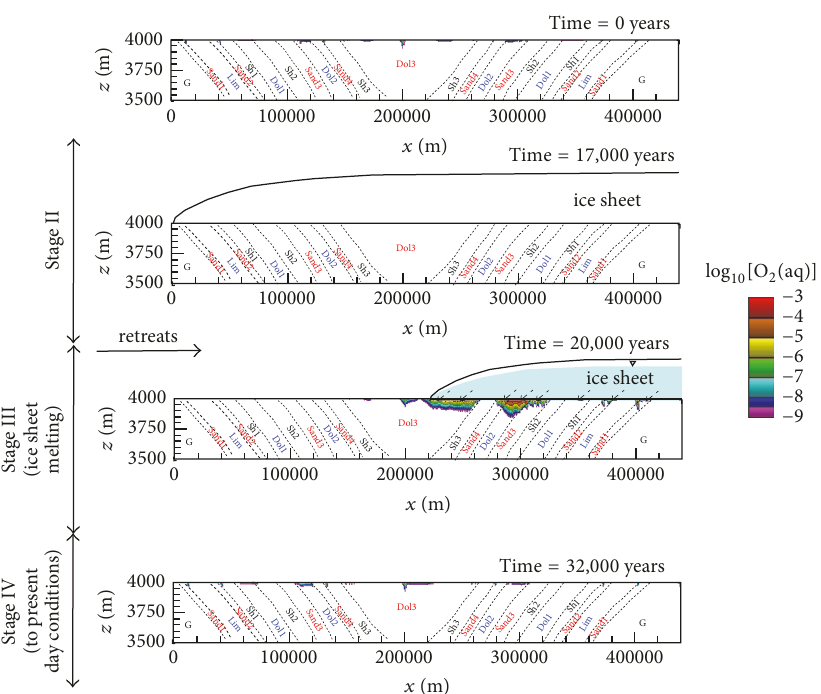
Figure 6: Spatial O 2 (aq) concentration distributions at different times for the base case simulation (i.e., at 0, 17,000, 20,000, and 32,000 years), corresponding to the initial condition, the end of Stage II, Stage III, and the final condition. O 2 concentrations in moll −1